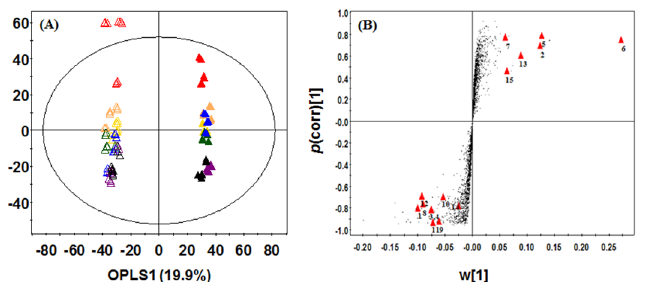
Fig 2. (A) Orthogonal partial least squares-discriminant analysis (OPLS-DA) score plot and (B) loading S-plots of different cultures in the UPLC-Q-TOF-MS based dataset. The significantly different metabolites ( ▲ ) according to different fermentation condition are highlighted in the S-plot. The numbering of metabolites is identical to that in Table 1. ( 4 : Submerged fermentation, ▲ : Solid-state fermentation, red: 4 days, orange: 6 days, yellow: 8 days, green: 10 days, blue: 12 days, violet: 14 days, black: 16 days. 1: N.I.1, 2: N.I.2, 3: N.I.3, 4:: N.I.4, 5: Agonodepside B, 6: Rotiorin, 7: Verrucosidin, 8: N.I.5, 9: Andrastin A, 10: N.I.6, 11: N.I.7, 12: N.I.8, 13: Ochrephilone, 14: Andrastin C, 15: N.I.9)